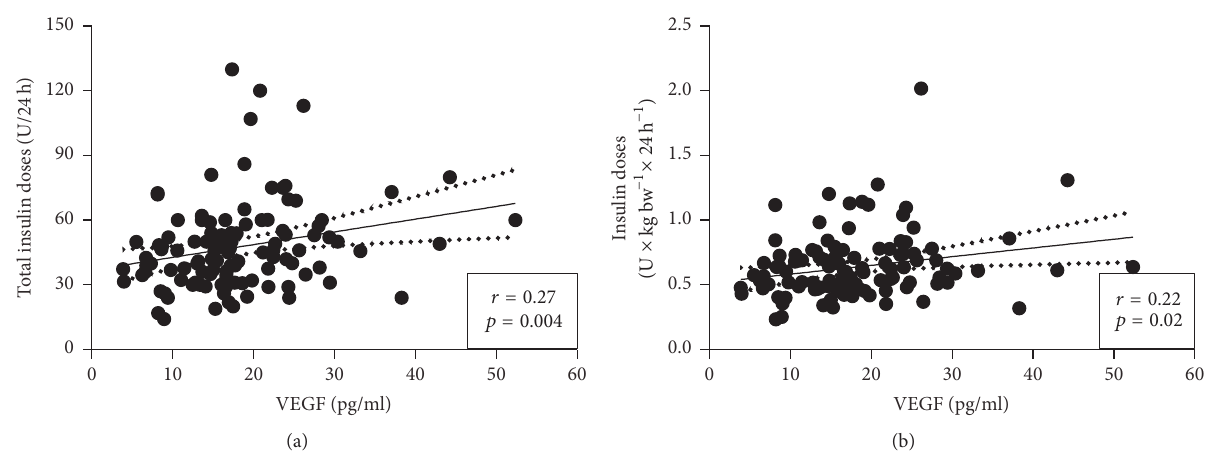
Figure 2: Plasma levels of VEGF correlate to exogenous insulin needs in patients with type 1 diabetes. The circulating plasma levels of VEGF were correlated to both the total exogenous insulin doses (a) and exogenous insulin doses adjusted for body weight (b) in patients with long-standing ( > 10 years) T1D ( 𝑛 = 115 ). Correlations were calculated using nonparametric Spearman correlation.